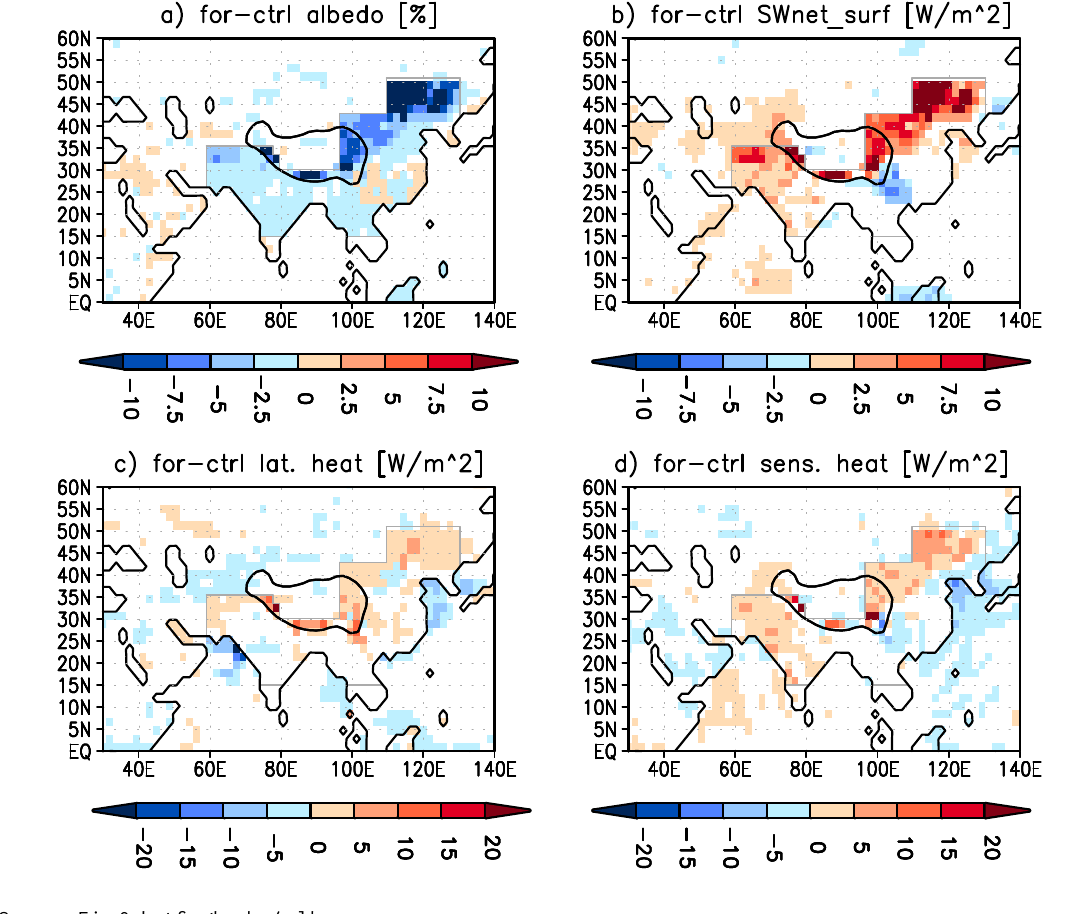
Fig. 10. Same as Fig. 9, but for the dry/cold